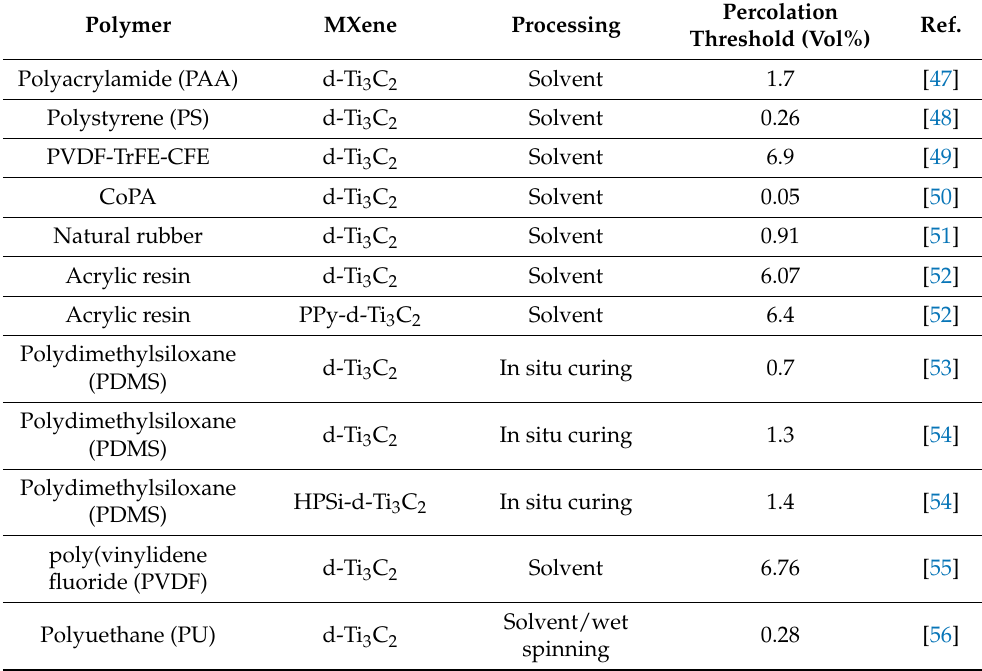
Table 3. Percolation threshold of various MXene polymers.